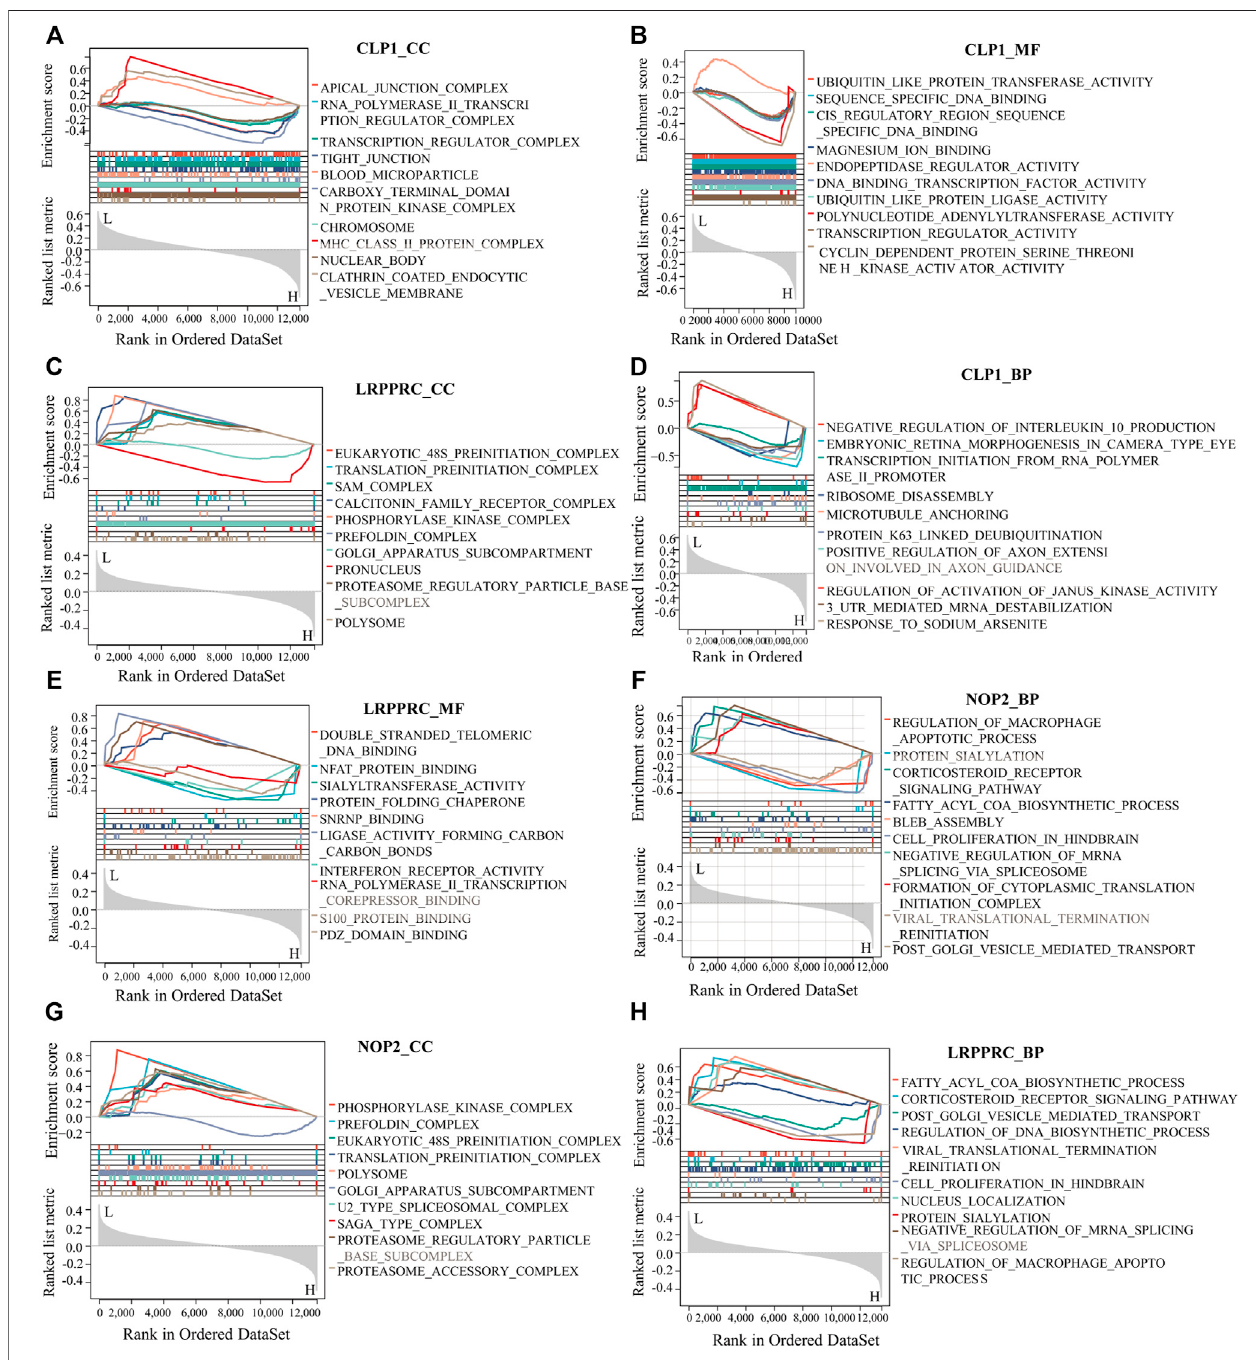
FIGURE 9 | GSEA-GO analysis of key genes. (A – H) : The results of functional enrichment of GSEA-GO (including BP, CC, and MF) showing CLP1, YTHDC1, LRPPRC, and NOP2 respectively displayed.